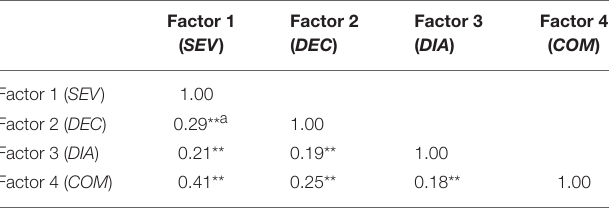
TABLE 3 | Between factors relations in the final version of